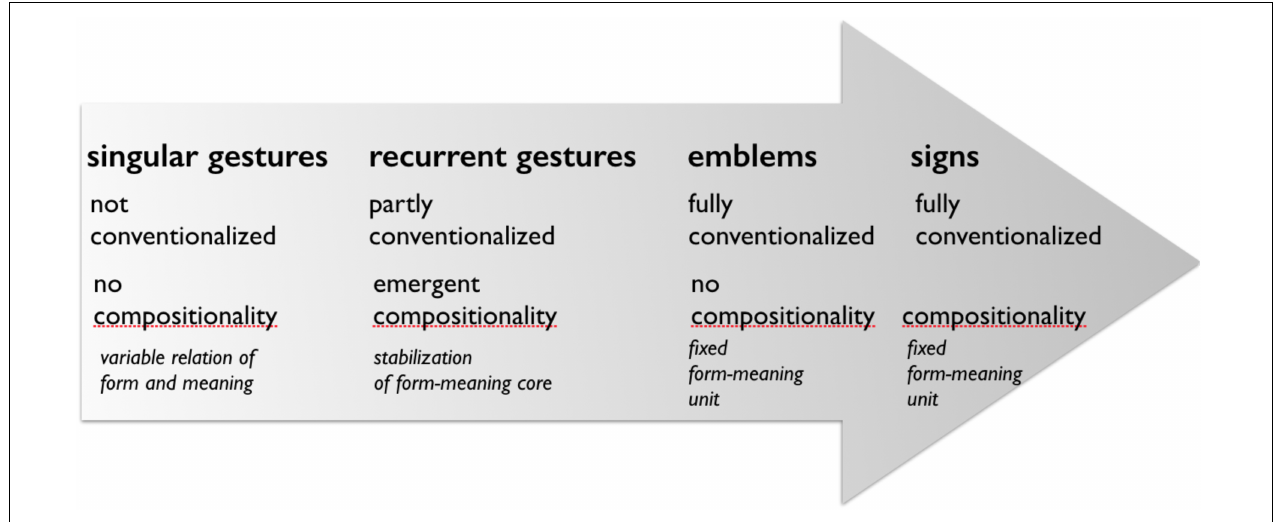
FIGURE 6 | Gesture change: historical development from gesture to sign in terms of degree of conventionalization and compositionality as an emergent hybridization.